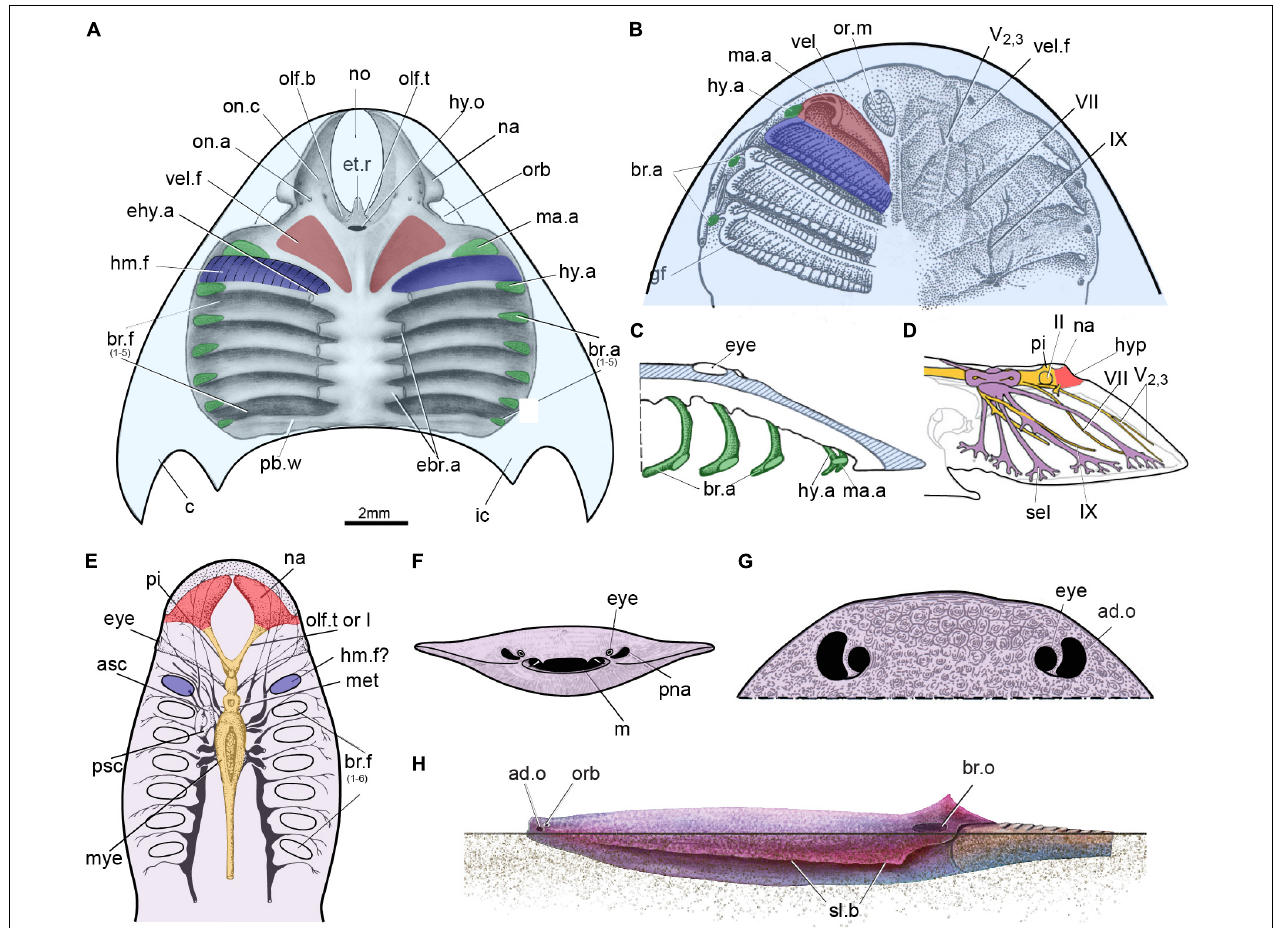
FIGURE 4 | The possible hyomandibular pouch in the stem-gnathostomes. (A) Roof of the oralobranchial cavity of Shuyu from the Silurian of China. (B–D) Roof of the oralobranchial cavity of Scolenaspis from the Early Devonian of Spitsbergen, with velum, gill arch, and gills reconstructed on left-hand side, panel (B) in ventral view, panel (C) in sagittal view with attempted restoration of gill-arch elements; (D) cranial anatomy of osteostracan Norselaspis , composite reconstruction based on Janvier (1985), showing the mandibular branch of trigeminal nerve passed through the foremost canal, together with the maxillary branch. (E) Reconstruction of the internal structure of the heterostracan Poraspis pompeckji Brotzen (redrawn after Novitskaya, 1983). (F,G) An infraorbital opening in a infraorbital position in an amphiaspid heterostracan Gabreyaspis from the Early Devonian of Siberia, was interpreted as a displaced opening of the prenasal sinus (F) (Janvier, 1974), or an adorbital opening (G) (Janvier, 1996b) probably with an inhalent function for intake of clear water. (H) Amphiaspid heterostracan Kureykaspis using its adorbital opening for the intake of respiratory water when buried in sand. ad.o, adorbital opening; br.o, branchial opening; hyp, hypophysis; m, mouth; or.m, oral musculure; pna, prenasal sina; “sel” canal to the lateral field; sl.b, serrated lateral brim; other abbreviations as in Figures 1 , 2